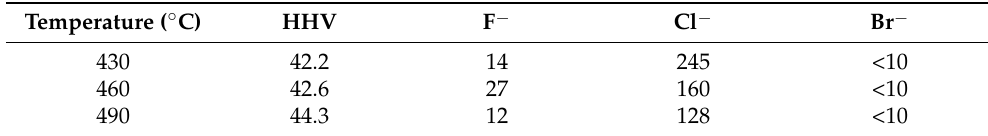
Table 10. HHV (MJ kg − 1 ) and halogen content (ppm) of the pyrolysis oils of PT-Film pyrolyzed at different temperatures.